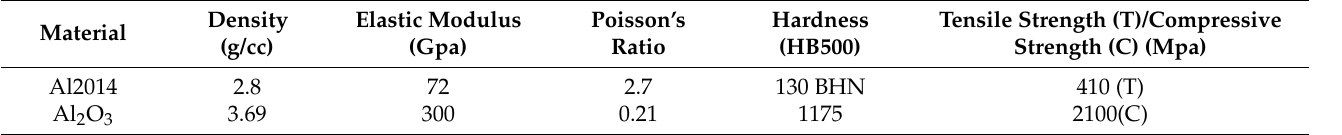
Table 2. The base alloy matrix and particle reinforcement materials’